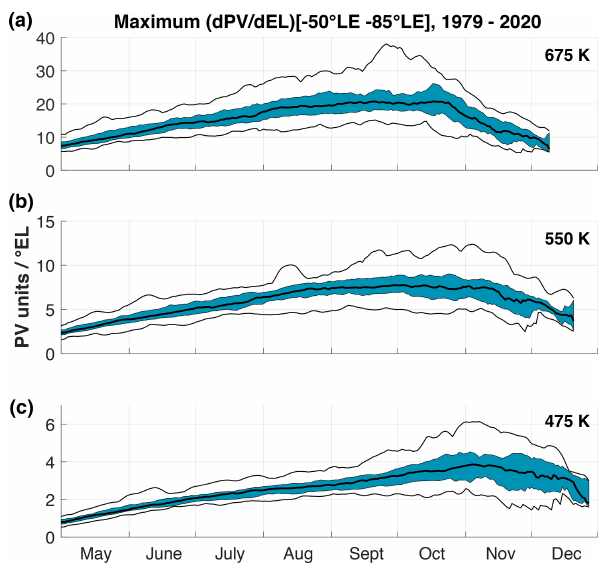
Figure 1. Evolution of daily maximum PV gradient in the period 1979–2020, from (a) to (c) : 675, 550, and 475K. Median values are represented by the bold black curves. Blue areas show values between the 20th and 80th percentiles, while thin black curves rep- resent the maximum and minimum during the